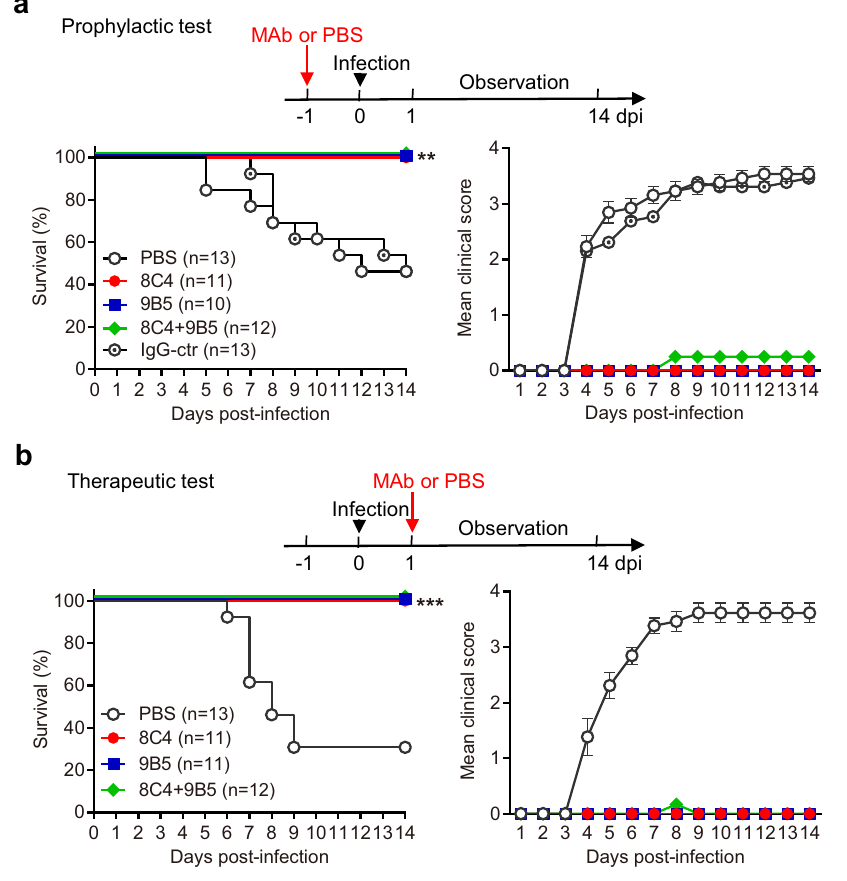
Fig. 2 | The in vivo protective ef fi cacy of the anti-CVA16 MAbs. In vivo prophy- lactic ef fi cacy ( a ) and therapeutic ef fi cacy ( b ) of MAbs 8C4, 9B5 and the 8C4+9B5 cocktail against CVA16 infection in mice. Upper panel: study outline. Lower panel: survival and clinical score. Clinical scores were graded as follows: 0, healthy; 1, reducedmobility;2,limbweakness;3,limbparalysis;4,death.Thenumberofmice in each group were indicated in the bracket. Survival rates of MAb-treated mice were compared with the mice inthe PBS-treated group.Statistical signi fi cancewas